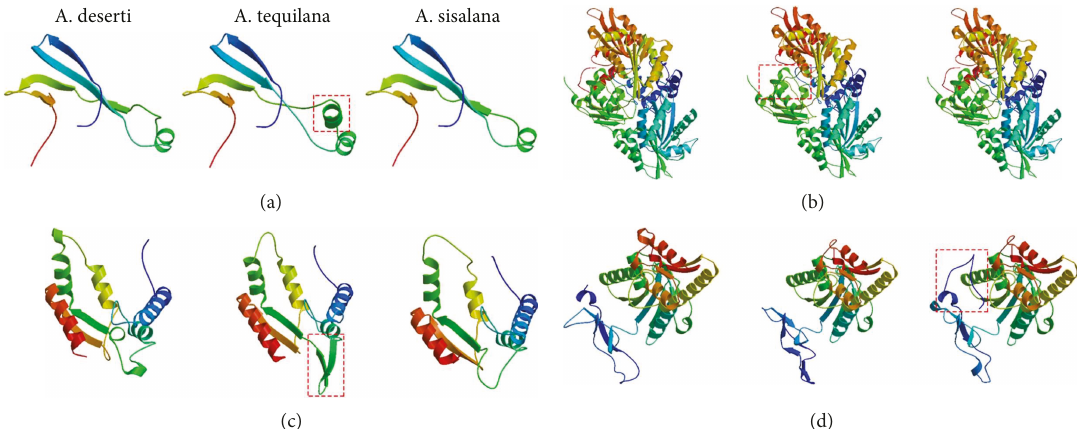
Figure 7: Protein structure model of 6G-fructosyltransferase (a), d-2-hydroxyglutarate dehydrogenase (b), gluconokinase (c), and 6-phosphofructokinase (d) in three Agave species by using Swiss-Model [33]. The signi fi cant structure di ff erence within species was marked in red dotted